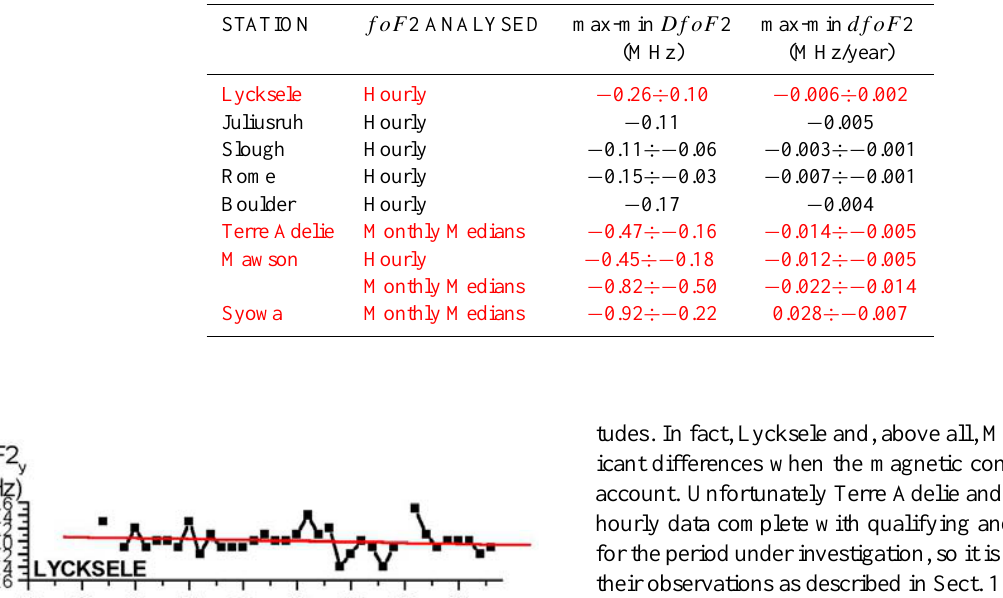
Table 4. Maximum and minimum f oF 2 trend rates (max-min Df oF 2) obtained along more than two solar cycles of observations made by mid and high latitude ionospheric stations (in red) and their respective yearly trend rates (max-min df oF 2). Both the quantities are referred to all the magnetic conditions and are obtained with the use of different regression models (adapted from Alfonsi et al., 2001, 2002).